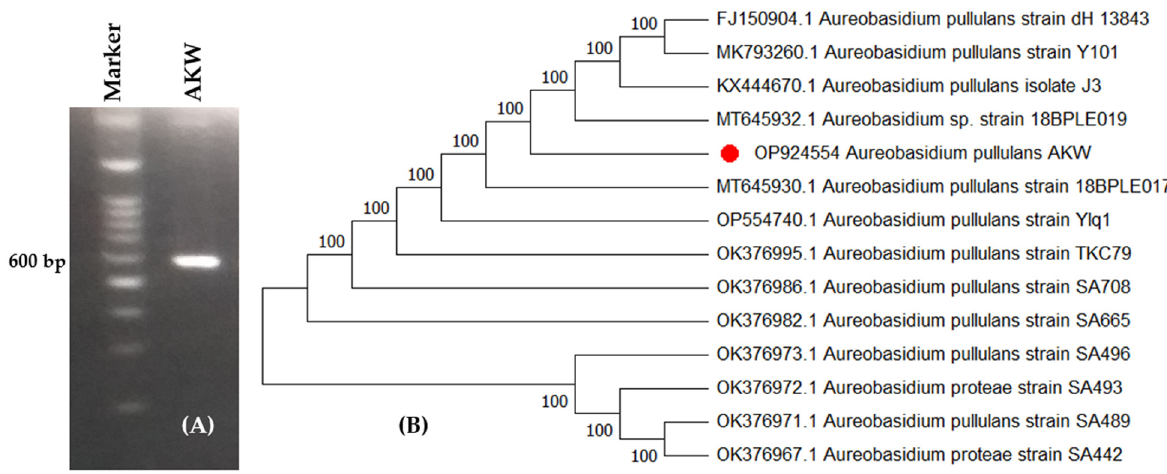
Figure 2. Agarose gel electrophoresis of the amplified bands of PCR product ( A ) and molecular phylogenetic tree based on partial ITS sequence ( B ) of A. pullulans AKW (OP924554), marked by a red dot.